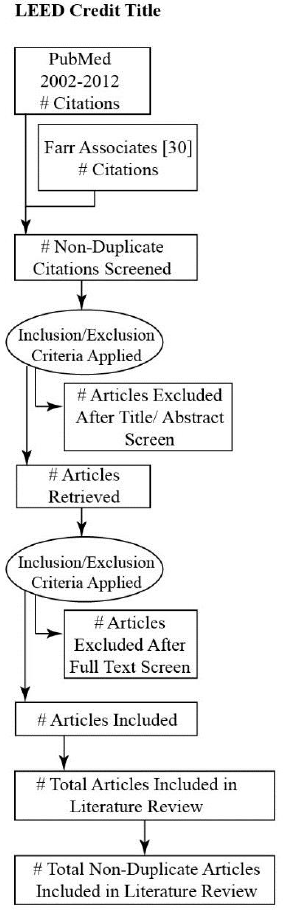
Figure 3. Flow chart of generic article inclusion criteria. Diagram adapted from PRISMA Flow Diagram